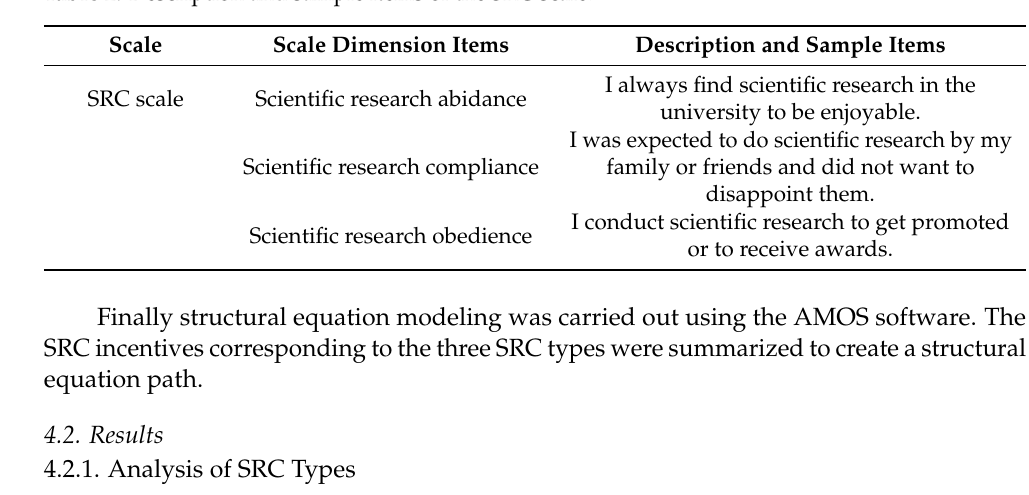
Table 2. Description and sample items of the SRC scale.